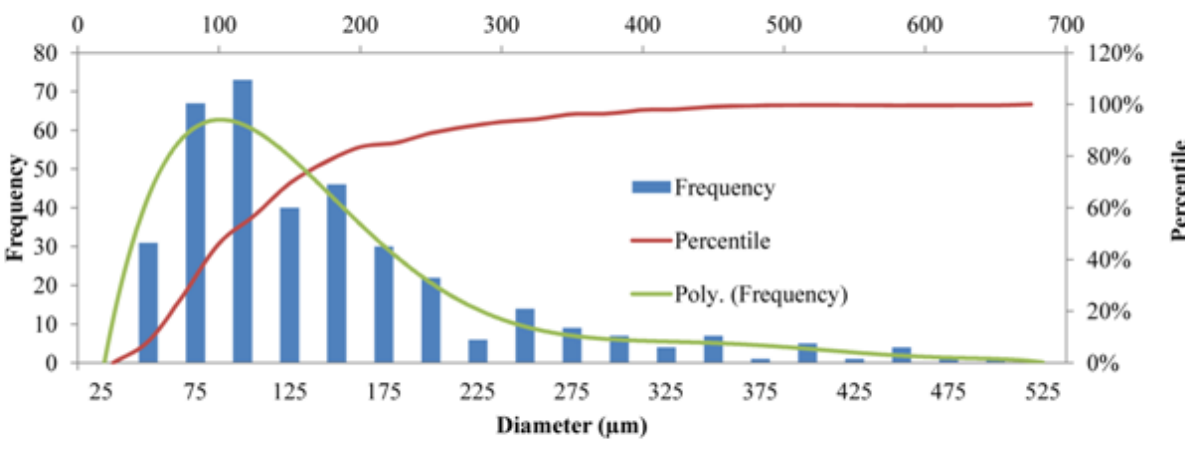
Figure 3. X-ray diffraction pattern of the EMAA powder and, inset, the morphology of EMAA